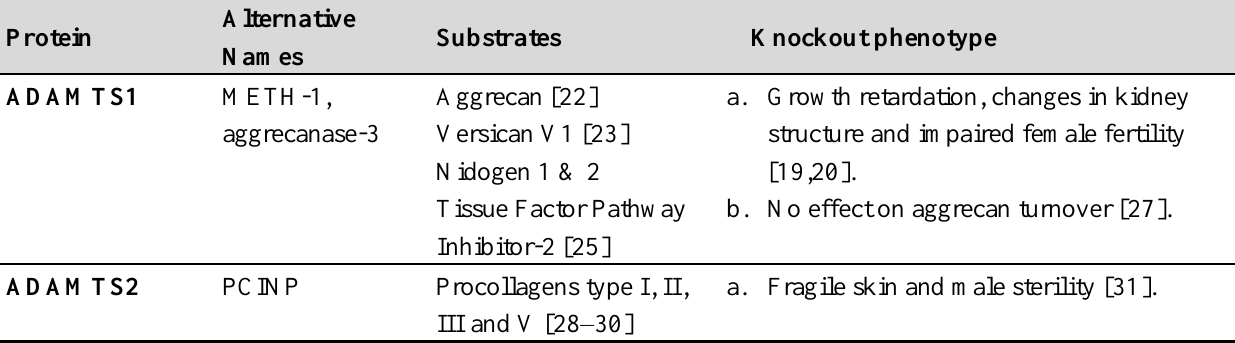
Table 1. Alternative names, substrates and knockout phenotypes of ADAMTS members implicated in angiogenesis and